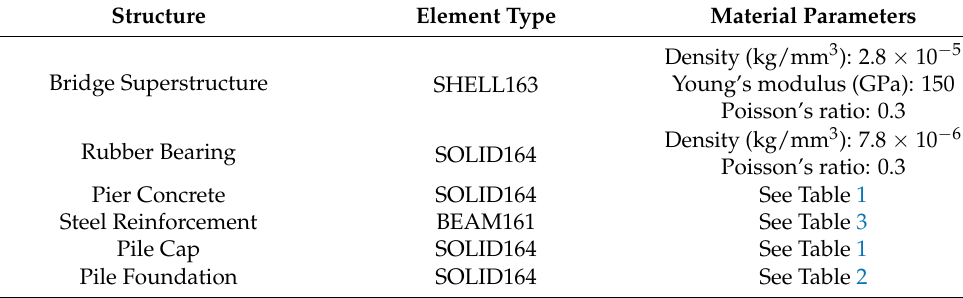
Table 6. Elements types and material parameters of whole bridge model.